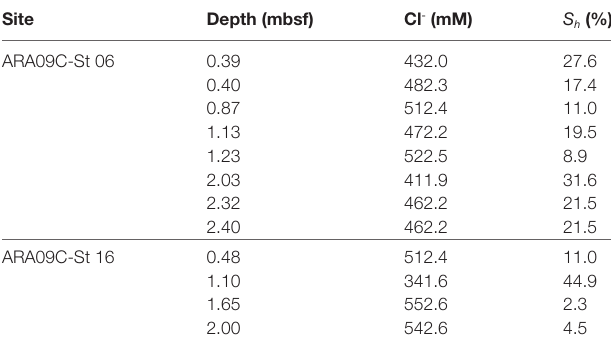
TABLE 3 | Gas hydrate saturation ( S h ) from Sites ARA09C-St 06 and ARA09C-St 16.